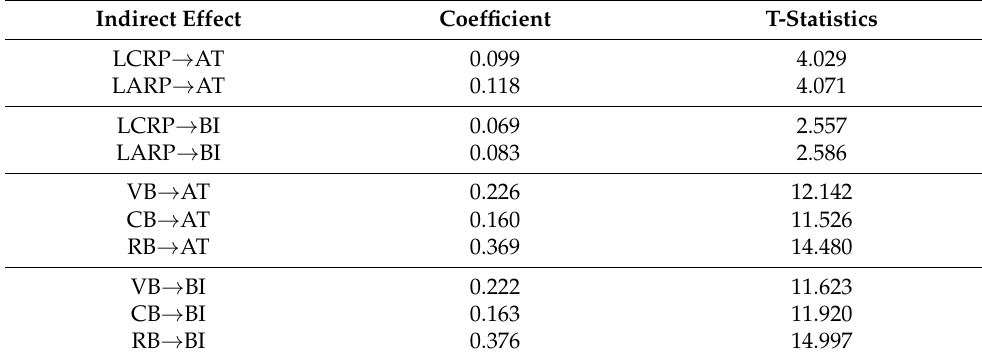
Table 7. Indirect effects of perceived benefit and low-risk perception.